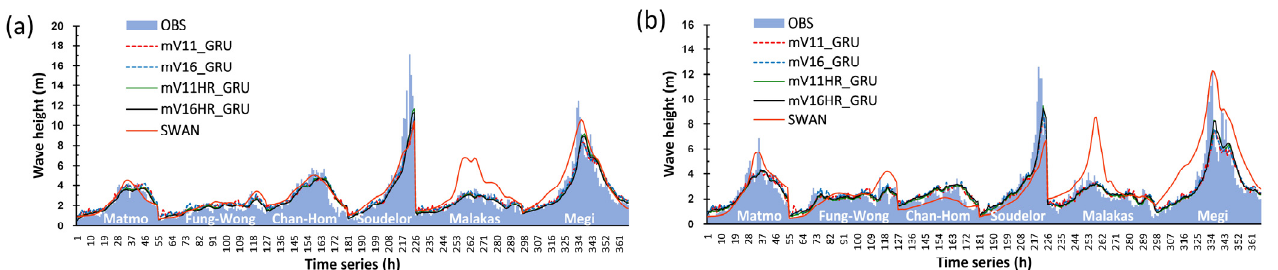
Figure 13. Wave heights predicted and measured using mV11_GRU, mV16_GRU, mV11HR_GRU, mV16HR_GRU, and SWAN at the: ( a ) Longdong buoy, ( b ) Guishandao buoy.